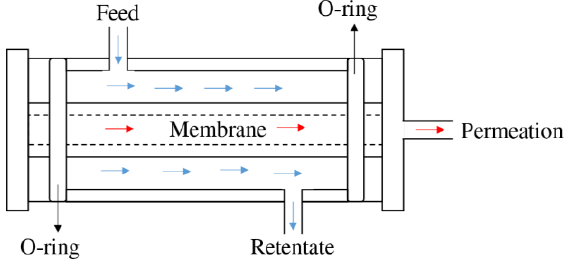
Figure 1. Schematic of membrane module.